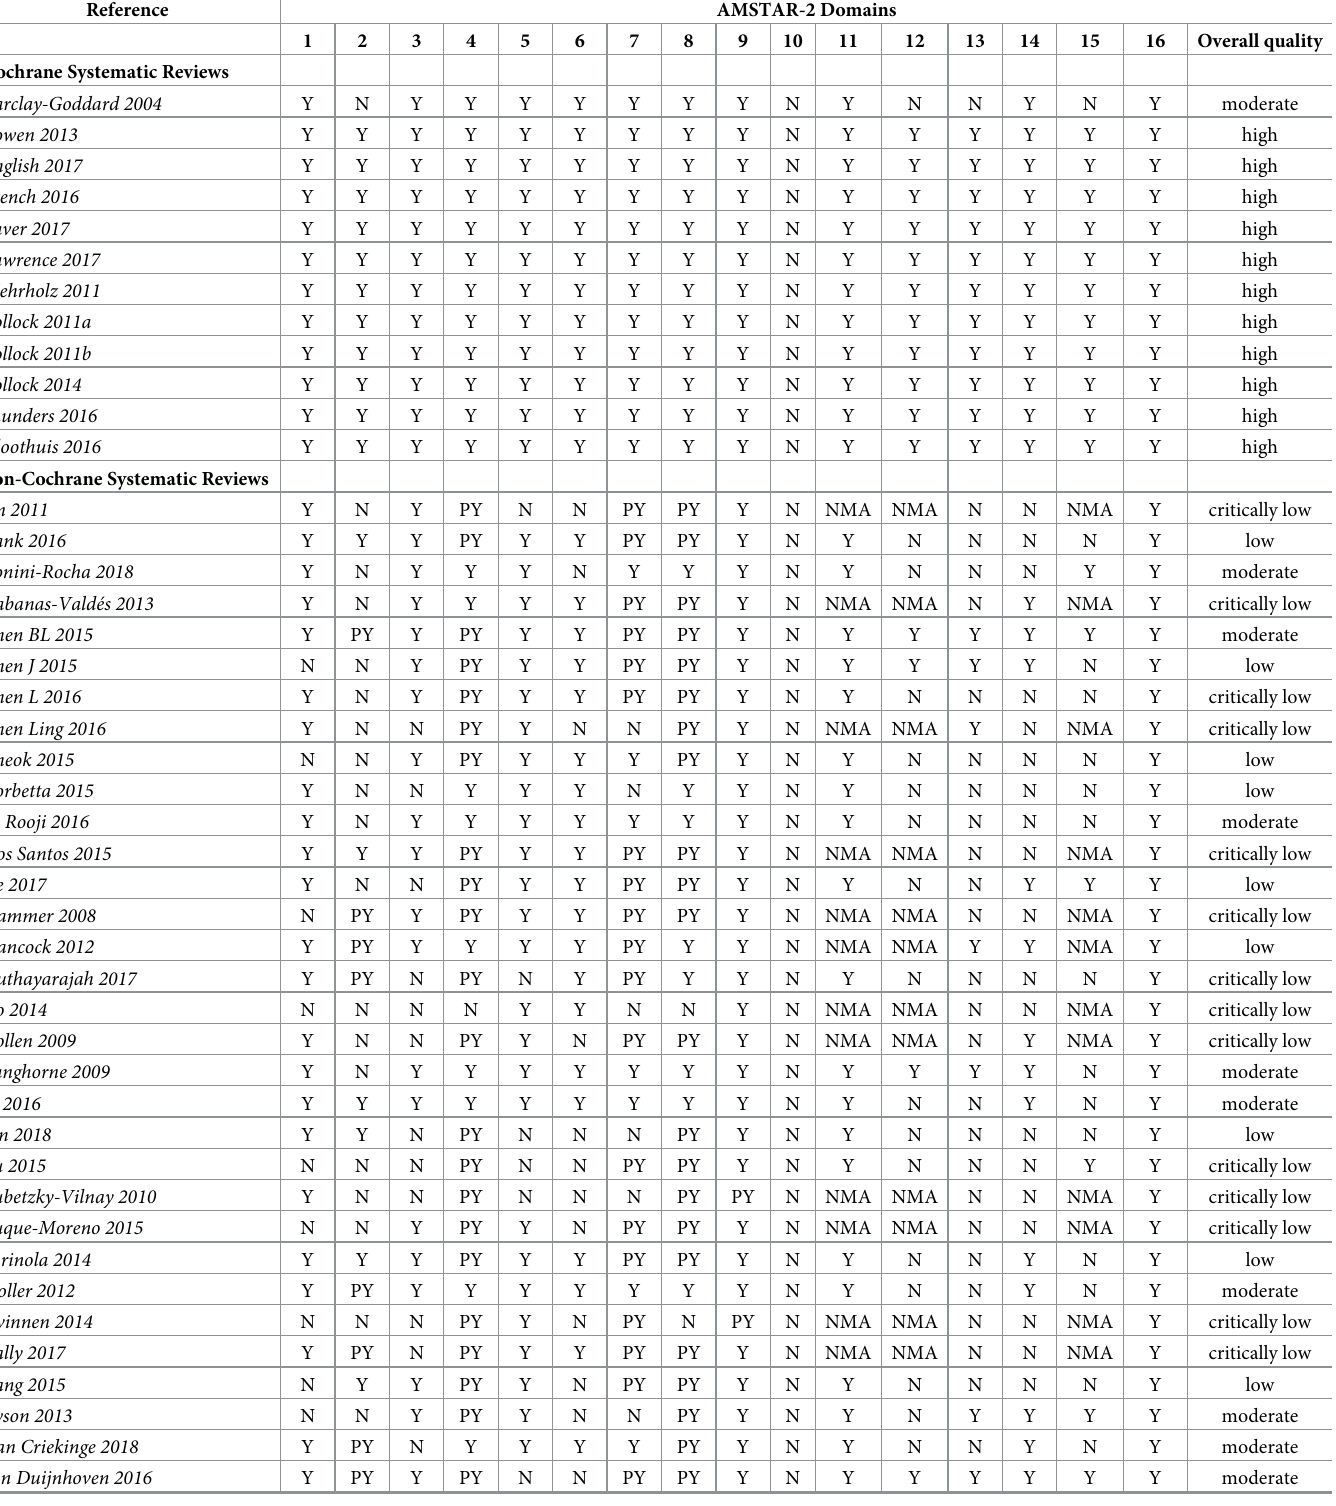
Table 2. AMSTAR-2